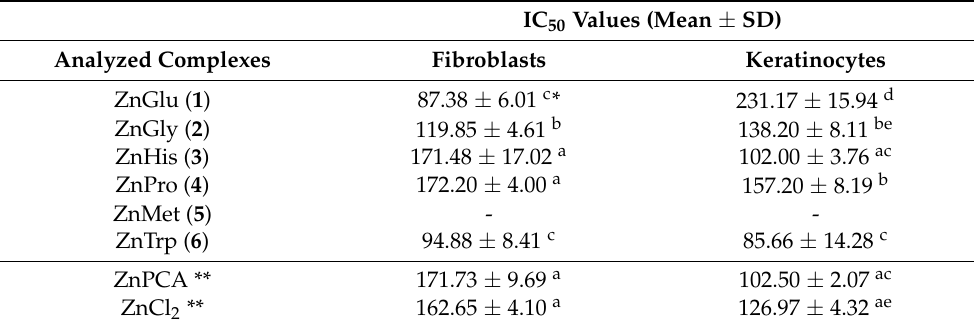
Table 1. The IC 50 values (mean ± SD) for all analyzed zinc complexes for human fibroblasts and keratinocytes. The IC 50 was calculated using the Hill Equation after the viable cell number was normalized relative to untreated